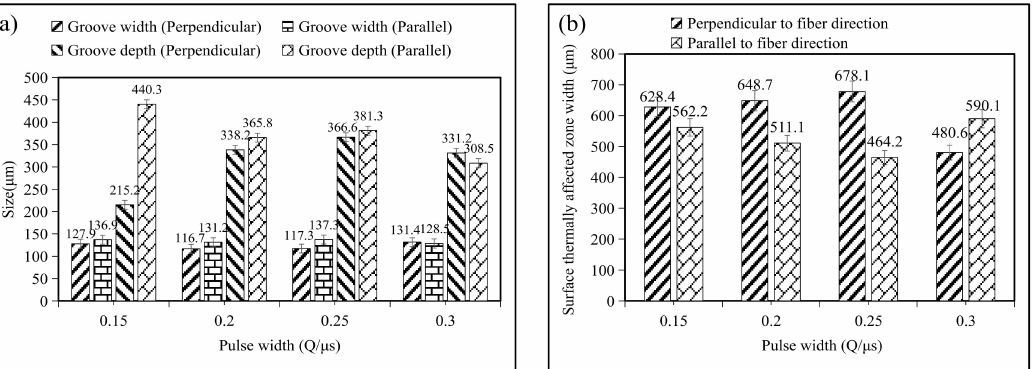
Figure 9. Effect of the pulse width on the composite surface groove (( a ). variation in groove width and depth; ( b ). variation in thermally affected zone